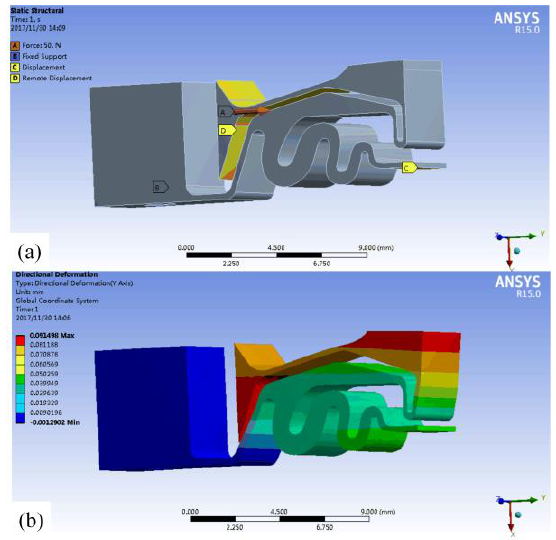
Figure 7. Stiffness calculation of the transmission flexible hinge. ( a ) Schematic diagram of applying force. ( b ) Deformation displacement diagram. force. ( b ) Deformation displacement